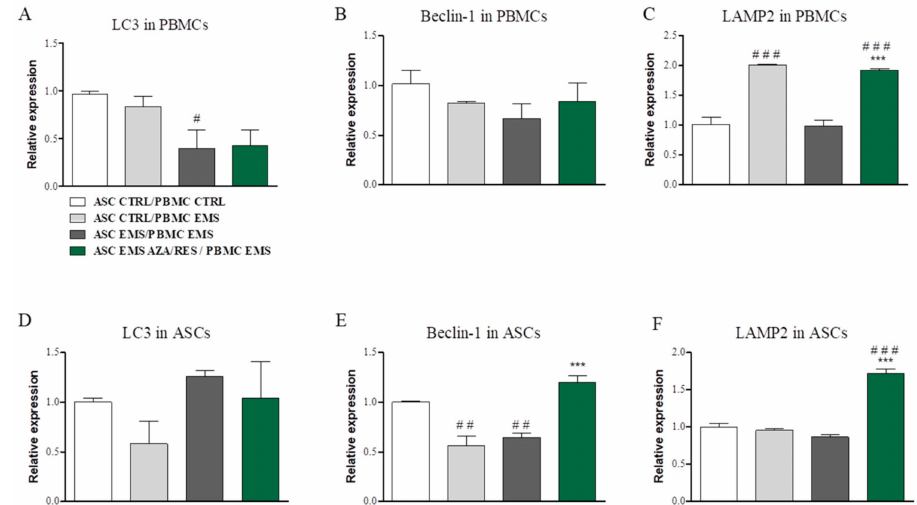
Figure 5. Evaluation of autophagic genes after co-culture of ASCs with PBMCs. Using RT-PCR expression of LC3 ( A ), Beclin-1 ( B ), and LAMP-2 in PBMCs were analysed ( C ). Similarly mRNA levels of LC3 ( D ), Beclin-1 ( E ) and LAMP-2 ( F ) were investigated in ASC. Statistical significance was labelled with hash (#) when comparing to control group (ASC CTRL /PMBM CTRL ) and asterisk (*) when comparing to EMS group (ASC EMS /PBMC EMS ). Results expressed as mean ± S.D. # p < 0.05; ## p < 0.01; ###, *** p <